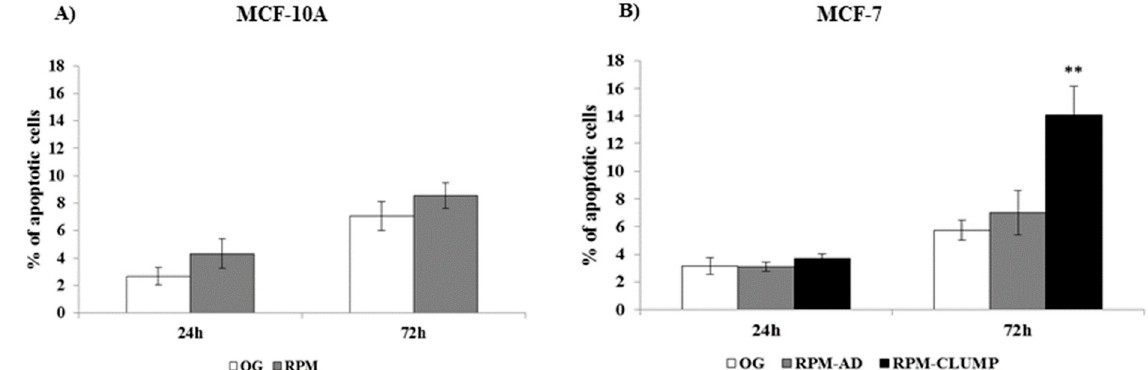
Figure 9. Apoptosis analysis in MCF-10A ( A ) and MCF-7 ( B ) cells at 24 and 72 h after exposition to weightlessness. Bar charts/graphs show the percentage of apoptotic cells (Annexin V+/7-AAD-); each column represents the mean value ± SD of three independent experiments. ** p < 0.01 vs. OG by ANOVA followed by Bonferroni post-test. OG—on ground.